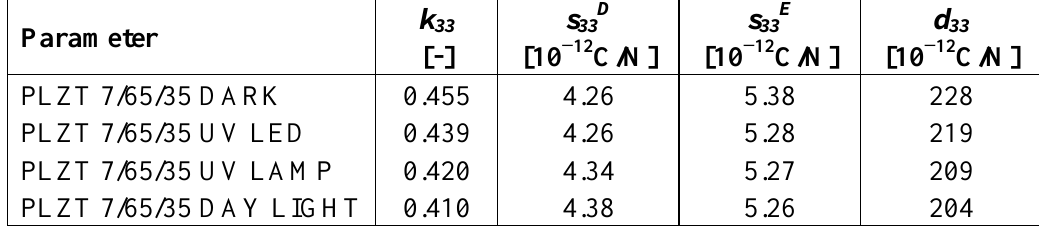
Table 2. Difference of piezoelectric coefficients and elastic constants in unilluminated (dark) and illuminated conditions for the manufactured PLZT